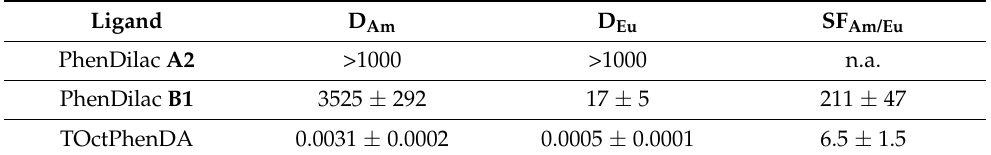
Table 3. Separation of Am(III) and Eu(III) from 3 M HNO 3 by 1.0 mM ligands PhenDilac A2 , PhenDilac B1 and TOctPhenDA in 1,2-dichloroethane. Adapted with permission from ref. [165]. Copyright 2017 American Chemical Society.